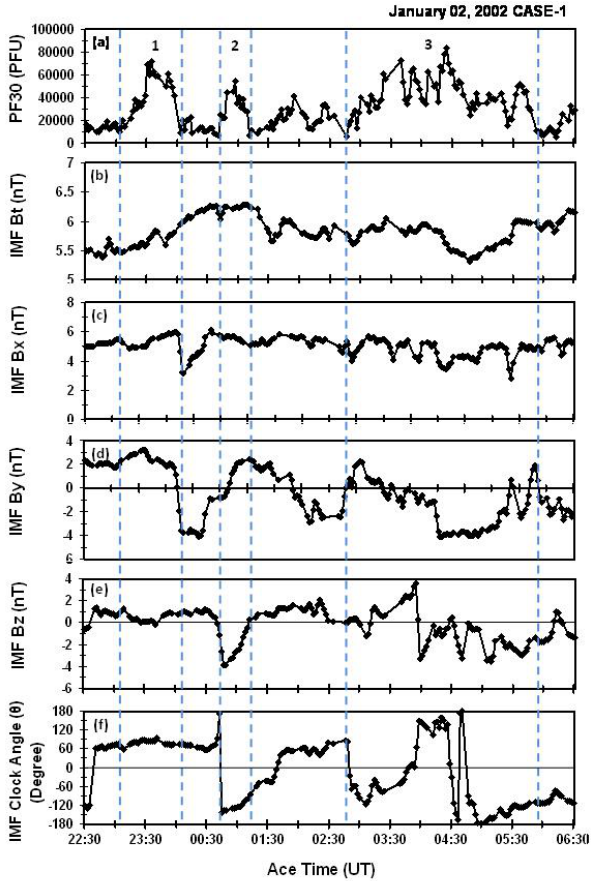
Fig. 9a. ACE magnetic field data for 2 January 2002. From top to bottom, panels give PF30, IMF strength, IMF B x , IMF B y , IMF B z , and IMF clock angle versus time. PF30 was added to guide the features in Cluster data. Cluster data were shifted to the ACE times concurrently to account for the solar wind convection time from ACE to Cluster. Horizontal axis indicates the time at ACE spacecraft.